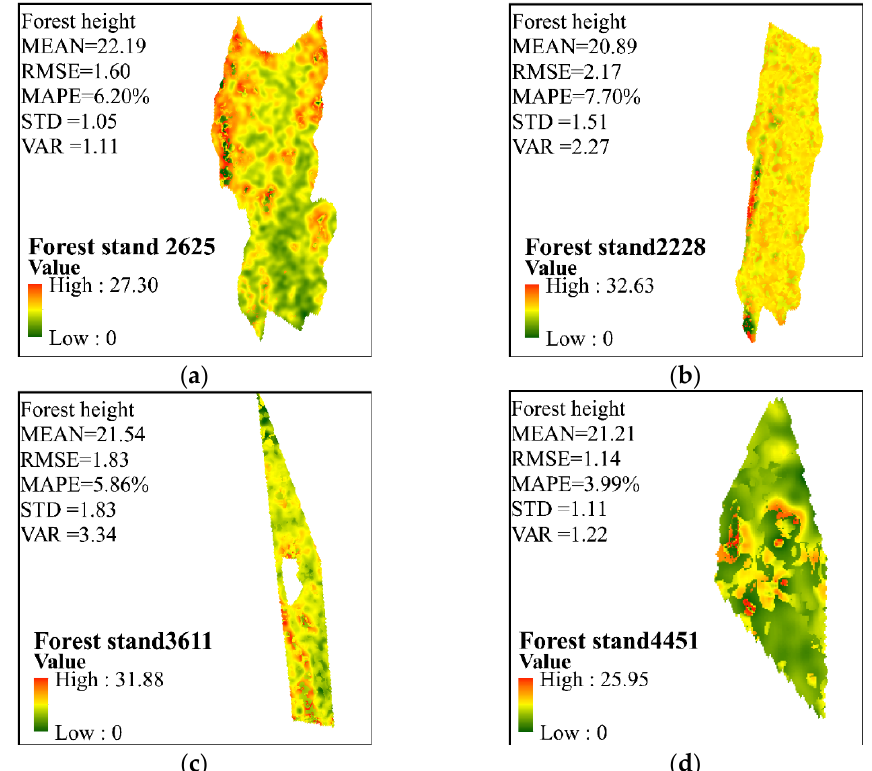
Figure 11. Forest height mapping in four forest stands was accomplished using coherence magnitude and three ‐ stage hybrid iterative application algorithms. ( a ) Stand 2625, ( b ) stand 2228, ( c ) stand 3611, and ( d ) stand 4451.